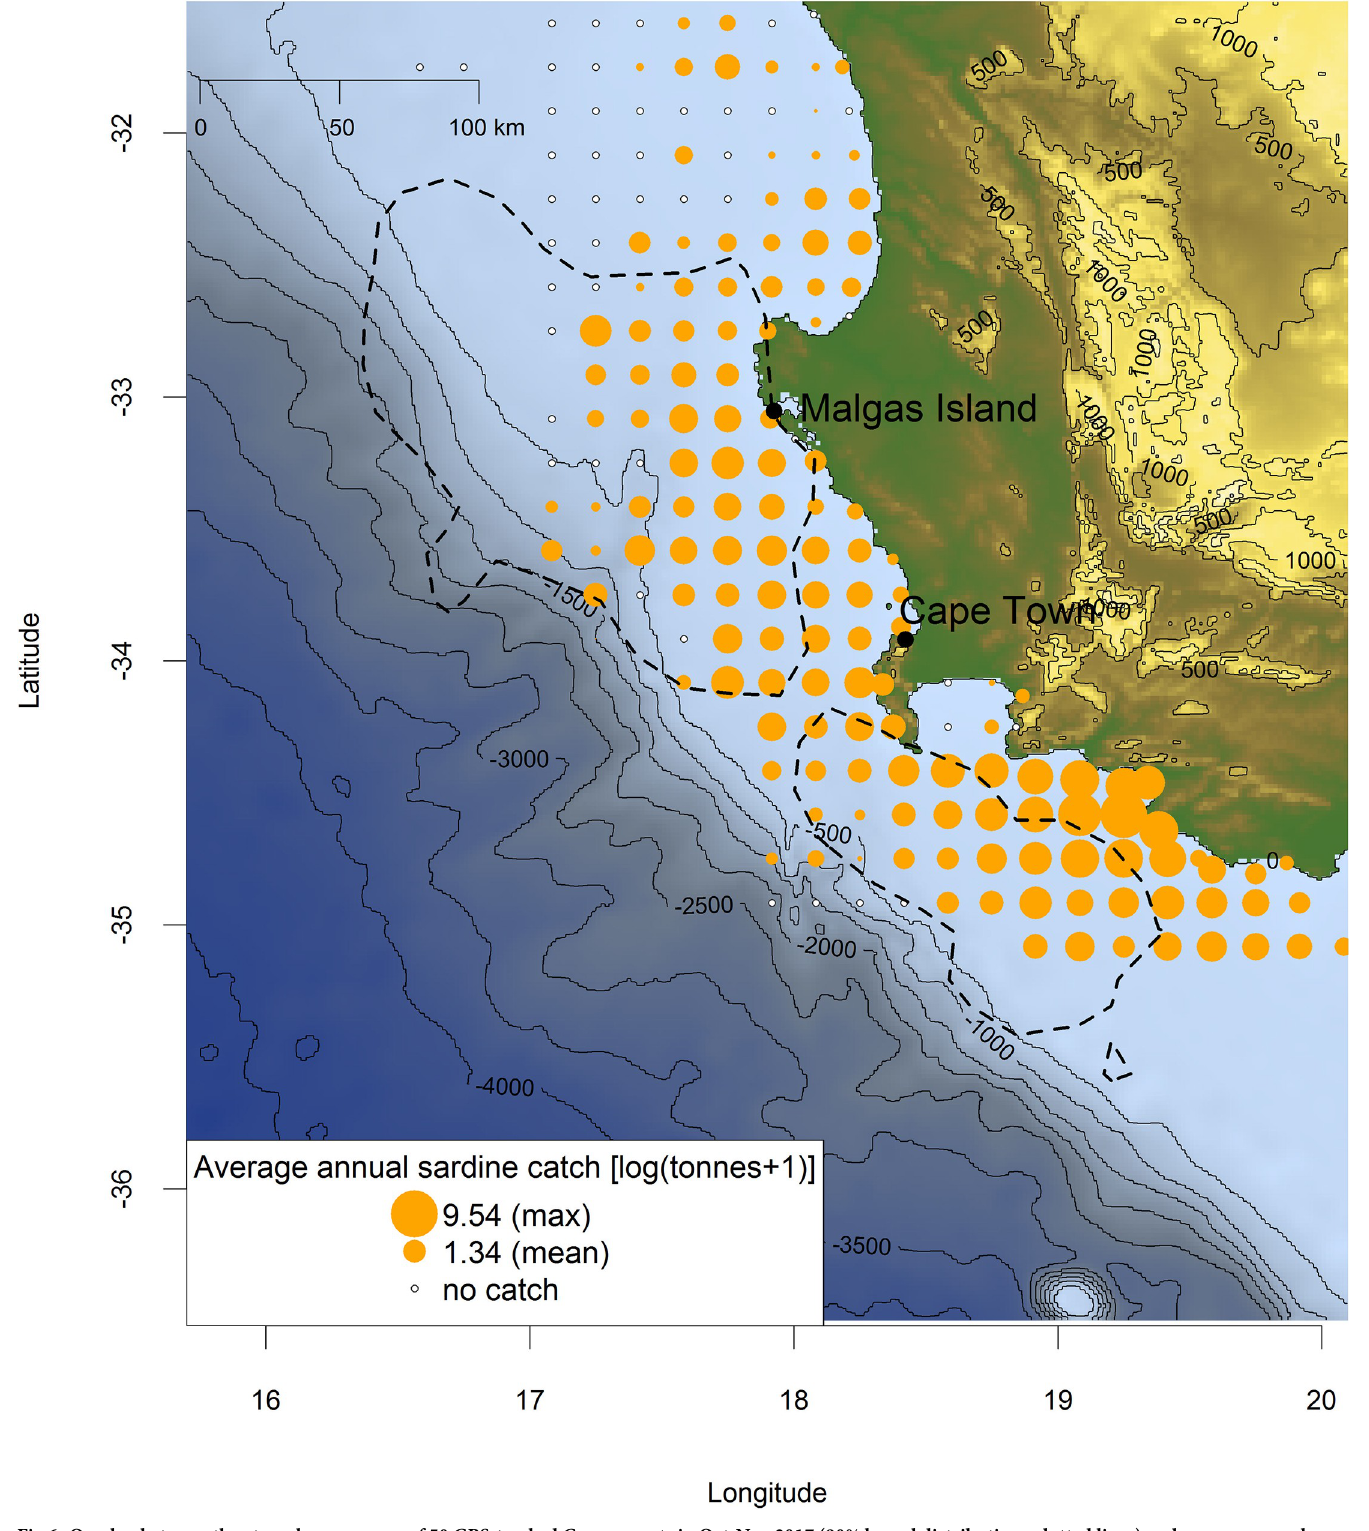
Fig 6. Overlap between the at-sea home-ranges of 50 GPS-tracked Cape gannets in Oct-Nov 2017 (90% kernel distributions, dotted lines) and average annual sardine catch by purse-seiners reported at a 10x10 nautical mile grid scale (log tonnes+1; orange dots) in 2008–2015. The size of orange dots increases with catch value from 0.20 to 9.54. White dots represent no catch in the fishing area. Blue shades indicate bathymetry (R package marmap). https://doi.org/10.1371/journal.pone.0210328.g006 PLOS ONE | https://doi.org/10.1371/journal.pone.0210328 February 6,